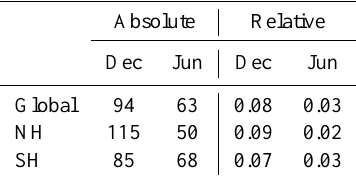
Table 1. Summary of absolute (units cm − 3 (mg m − 2 day − 1 sulphur) − 1 ) and relative CCN sensitivities resulting from the DMS flux perturbations.